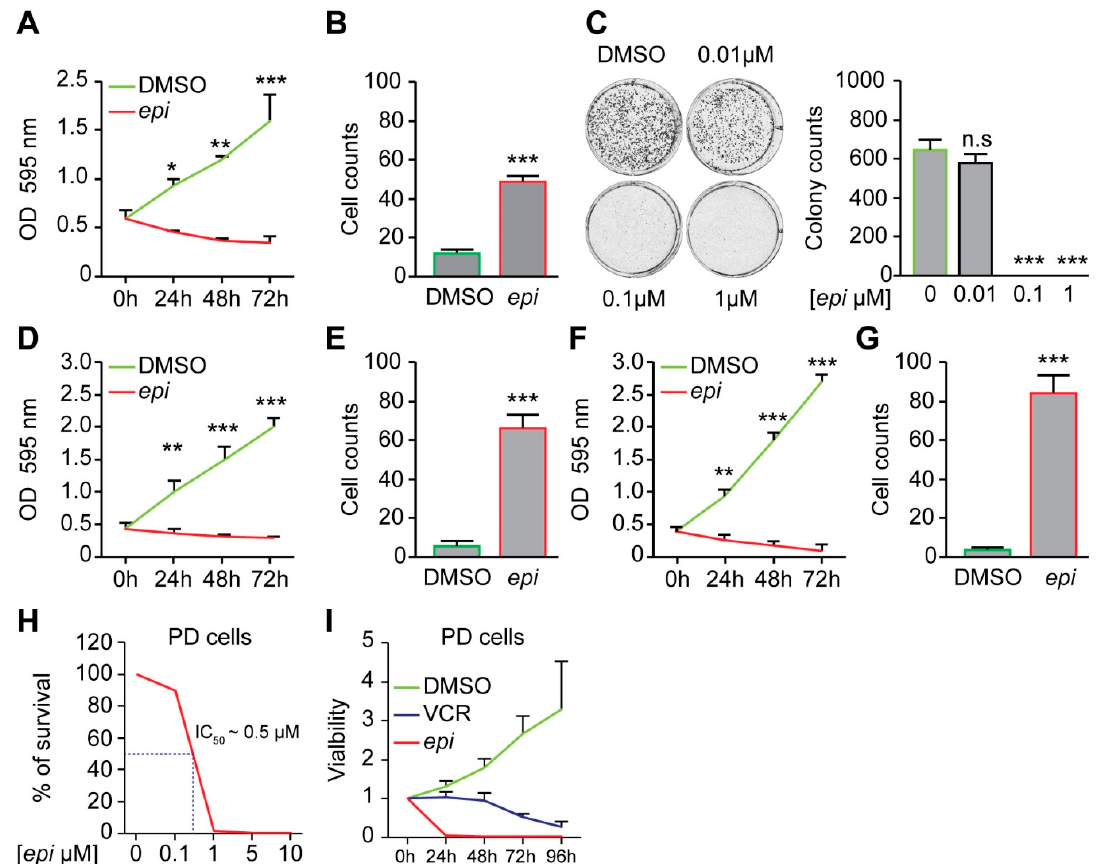
Figure 2. Epi -enprioline mediates reduced proliferation and cell survival. ( A ) VCR-20 cells were treated with 0.5 µM epi -enprioline and cell proliferation was evaluated at different time points during the course of 72 h. (mean ± SEM; n = 3). * p < 0.05, ** p < 0.01, *** p < 0.001 compared to control cells (ANOVA, Tukey’s test). ( B ) VCR-20 cells were treated with 0.5 µM epi -enprioline and stained with PI for detecting dead cells (mean ± SEM; n = 3). ( C ) VCR-20 cells were treated with the indicated concentrations of epi -enprioline for 15 d for clonogenic determinations. Representative well and quantitative data are shown (mean ± SEM; n = 3). n.s. = non-significant, *** p < 0.001 compared to control cells (ANOVA, Tukey’s test). ( D ) SK-N-AS-VCR-20 cells were treated with 1.2 µM epi -enprioline for a crystal violet proliferation assay at different time-points during the course of 72 h. (Mean ± SEM; n = 3). ( E ) SK-N-AS-VCR-20 cells were treated with 1.2 µM epi- enprioline and stained with PI for detecting dead cells (mean ± SEM; n = 3). ( F ) UKF-NB-4-VCR-50 were treated with 3 µM epi -enprioline and cell proliferation was evaluated at different time-points during the course of 72 h. (Mean ± SEM; n = 3). ( G ) UKF-NB-4-VCR-50 cells were treated with 3 µM epi -enprioline and stained with PI for detecting dead cells (mean ± SEM; n = 3). ( H ) LU-NB-2 patient-derived xenograft (PDX) cells were treated with epi -enprioline and percentage of surviving tumor cells at different concentrations is shown. ( n = 3). ( I ) Cell viability of treated LU-NB-2 PDX cells was assessed at different time-points using the CellTiter-Glo cell viability assay. (mean ± SEM; n = 3). VC = vincristine; epi = epi-enprioline.